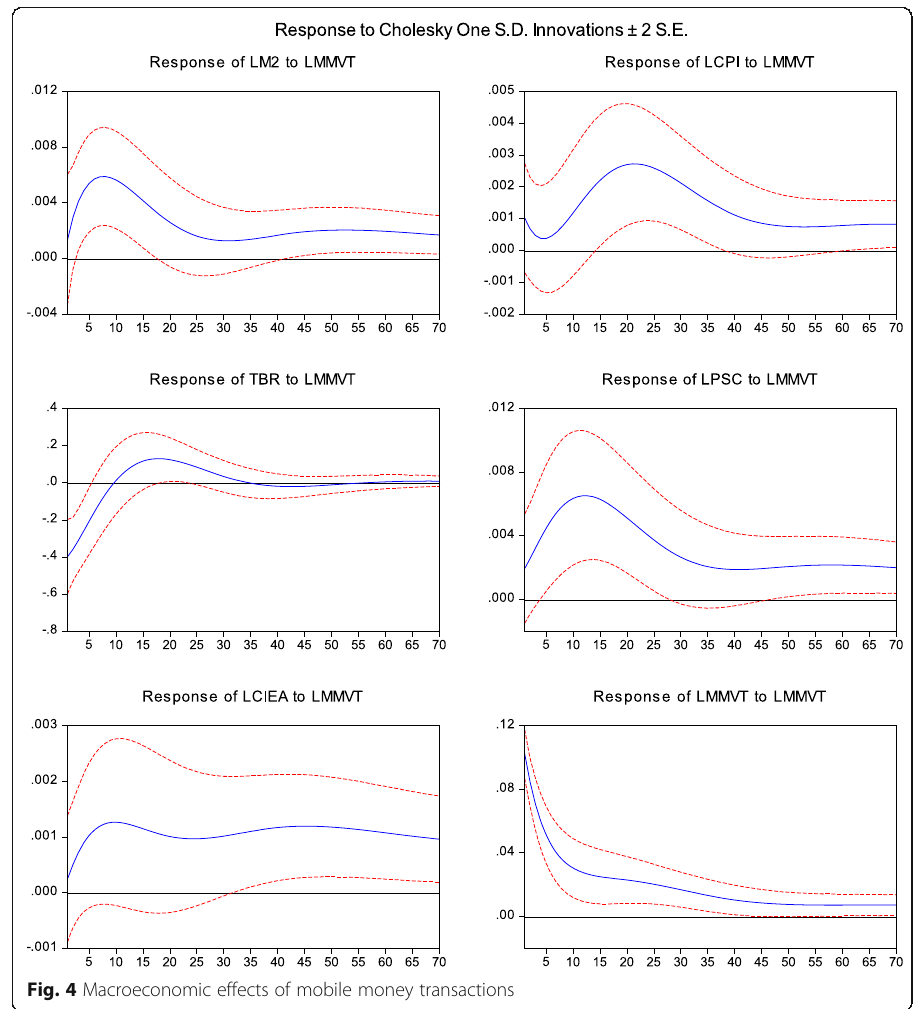
Fig. 4 Macroeconomic effects of mobile money